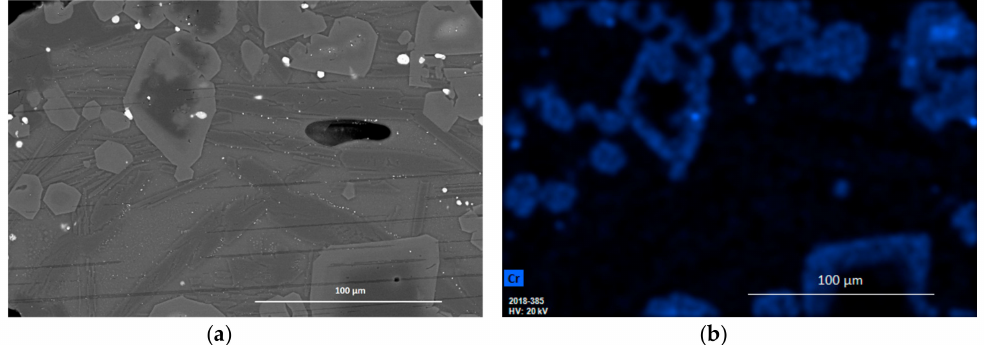
Figure 5. ( a ) SEM-BSE image of HC FeCr slags showing zoned Mg(Cr,Al) 2 O 4 spinel crystals with a Al-rich core and Cr-rich border in a matrix of elongated (dark) enstatite (MgSiO 3 ) crystals, with small FeCr metal particles (white spots). ( b ) EDX Cr distribution map showing the presence of Cr in the spinel outer rims and metal